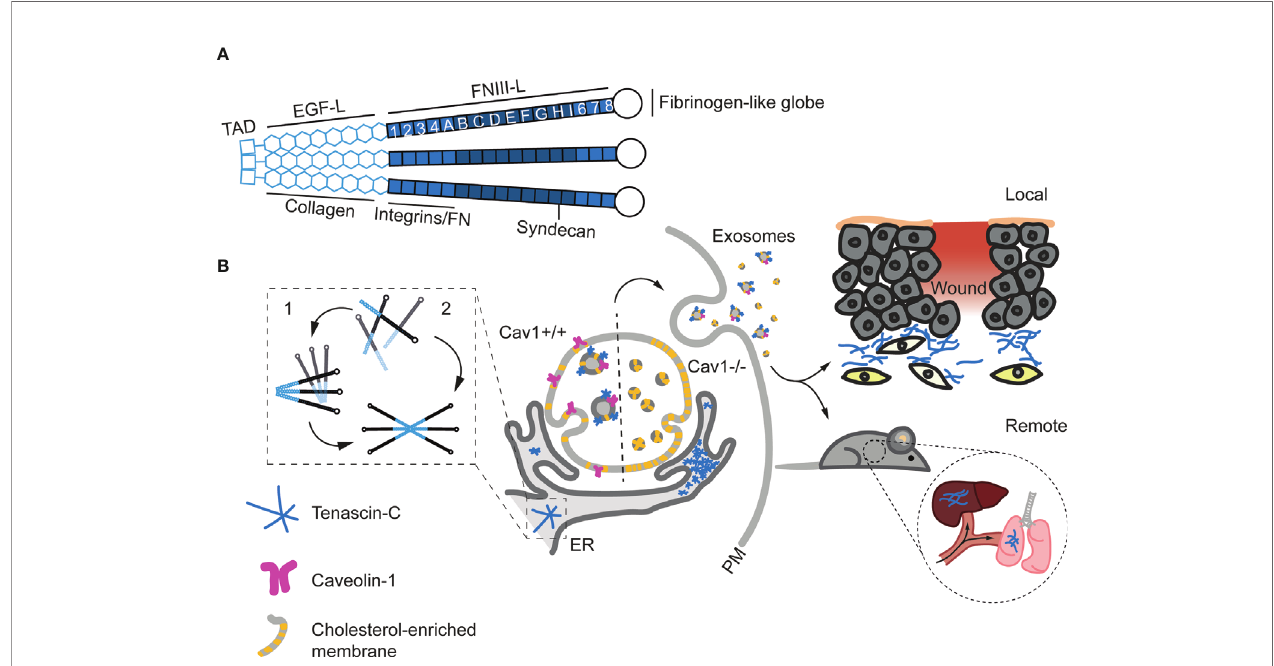
FIGURE 4 | Structure and exosomal secretion of TnC. (A) Structure of a trimer of TnC. Tenascin monomers bind via the tenascin assembly domain (TAD) located at the N-terminus. Basic domains (EGF-Like and FNIII-Like) and the main binding sites to other ECM proteins and receptors are depicted. (B) Models for TnC biosynthesis. In model 1, hexabrachions are formed in a very rapid co-translational process where six monomers are simultaneously assembled. In model 2, the hexabrachion assembly take place in two steps. First, monomers form an intermediary trimer through a -helical coiled-coil interactions in the TAD. Subsequently, two trimers assemble in a hexamer that is stabilized by di-sulphide bonds. (C) Exosome-mediated TnC secretion. After biosynthesis in the ER, TnC is transported to multivesicular bodies (MVBs) in a Cav1 dependent manner (Cav1 +/+ ). The absence of Cav1 (Cav1 -/- ) increases the levels of cholesterol at MVBs and alters exosome formation, preventing the sorting of TnC onto exosomes and leading to the accumulation of TnC in the ER. Upon secretion, exosomal TnC can be locally deposited, or modulate the behavior of surrounding cells. On the other hand, exosomes can eventually reach the blood stream and generate new TnC nucleation points at distant organs and tissues